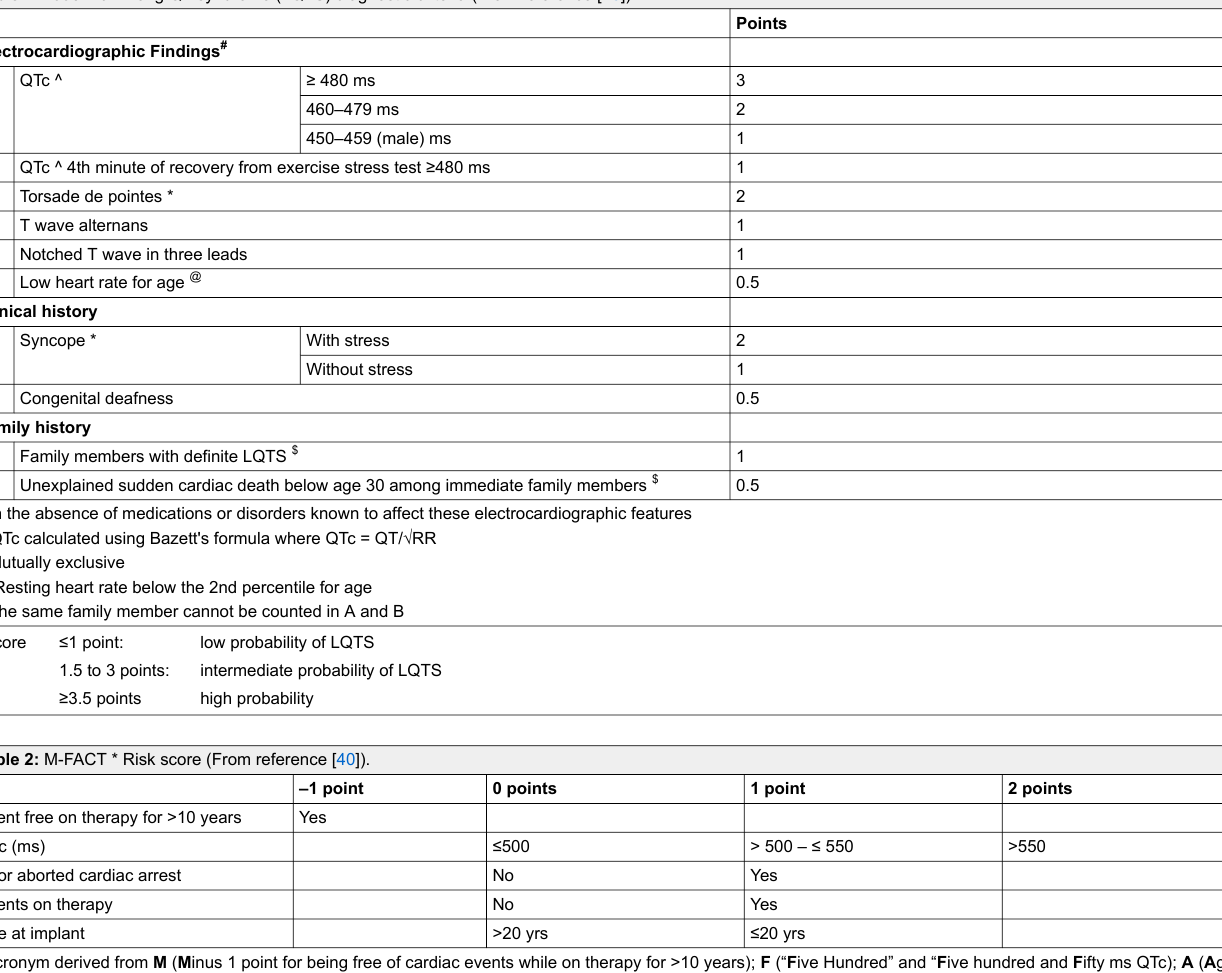
Table 1 : 1993–2012 long QT syndrome (LQTS) diagnostic criteria (From reference [13]). Electrocardiographic Findings #